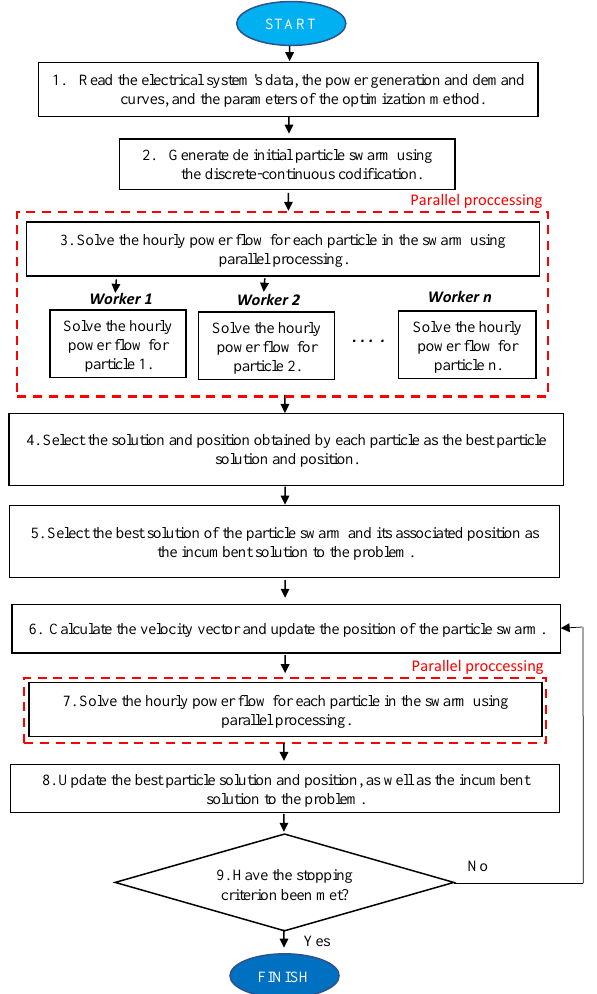
Figure 2. Discrete–Continuous Parallel version of the Particle Swarm Optimization algorithm